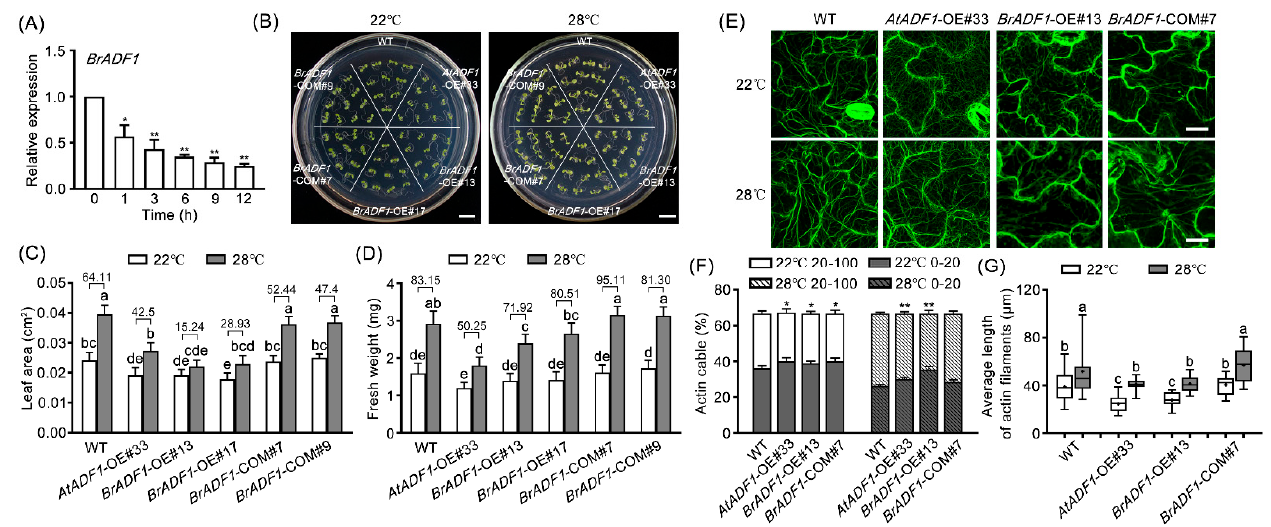
Figure 5. BrADF1 is a negatively regulator in plant growth and the stability of actin filaments under high temperature. ( A ) The relative expression of BrADF1 in 7-day-old Chinese cabbage “DH” line “FT” seedlings treated at 28 ◦ C for 1, 2, 4, and 6 d was determined by RT-qPCR. Chinese cabbage ACTIN was used as an internal control. Values are means ± SD from three independent replicate experiments (Student’s t -test, * p < 0.05, ** p < 0.01). ( B ) The thermal adaptation of WT, AtADF1 -OE#33, BrADF1 -OE#13, BrADF1 -OE#17, BrADF1 -COM#7, and BrADF1 -COM#9 was visualized. Scale bar = 1 cm. ( C , D ) Leaf area and fresh weight of WT, AtADF1 -OE#33, BrADF1 -OE#13, BrADF1 -OE#17, BrADF1 -COM#7, and BrADF1 -COM#9 seedlings at normal (22 ◦ C) and high (28 ◦ C) temperatures. At least 60 leaves from 30 seedlings were examined for leaf area, and at least 300 seedlings were examined for fresh weight, per genotype and treatment. Values are mean ± SD from three independent replicates. All of the statistical analyses use a one-way ANOVA followed by a Tukey’s post-hoc test. Significant differences were indicated by different lowercase letters. The number in the column is the percentage increase between normal and high temperature conditions. ( E ) Representative images of the actin filaments in leaf pavement cells of WT, AtADF1 -OE#33, BrADF1 -OE#13, and BrADF1 -COM#7 seedlings grown at 22 ◦ C and 28 ◦ C. Scale bar = 25 µ m. ( F ) The fluorescence intensity of actin cables. In the same condition, statistical analysis revealed a significant difference between WT (0–20 and 20–100) and genotypes (0–20 and 20–100). Values are means ± SD from three independent replicate experiments (n > 300 images from at least 30 seedlings per genotype and treatment). Student’s t -test, * p < 0.05, ** p < 0.01). ( G ) Average length of actin filaments in WT, AtADF1 -OE#33, BrADF1 -OE#13, and BrADF1 -COM#7 seedlings grown at 22 ◦ C and 28 ◦ C. Values are means ± SD from three independent replicate experiments. All of the statistical analyses use a one-way ANOVA followed by a Tukey’s post-hoc test. Significant differences were indicated by different lowercase